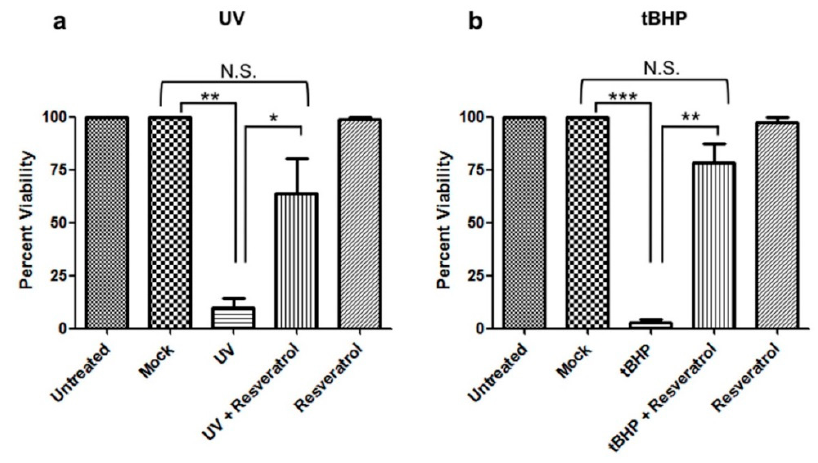
Figure 1. Resveratrol prevents apoptosis induced by UV-irradiation and tBHP treatment in C6 cells. C6 cells were pretreated with resveratrol and either ( a ) UV-irradiated or ( b ) treated with tBHP. Viability was determined 24 h later. C6 cells that were UV-irradiated or treated with tBHP showed a significant decrease ( p < 0.05) in viability compared to mock and untreated cells. C6 cells pretreated with resveratrol and then ( a ) UV-irradiated or ( b ) tBHP treated showed a significant increase ( p < 0.05) in viability compared to UV-irradiated or tBHP treated cells alone. ( a ) There was a significant difference in cell viability between mock vs. UV (**, p = 0.0026). UV treated cells pretreated with resveratrol showed a significant increase in viability vs. UV treated cells (*, p = 0.0354). Mock treated cells compared to UV treated cells pretreated with resveratrol showed no significant difference (Not Significant (N.S.), p = 0.0974). ( b ) There was a significant decrease in cell viability in tBHP treated compared to mock treated cells (***, p < 0.0001). C6 cells treated with tBHP and pretreated with resveratrol showed a significant increase in cell viability compared to tBHP treated cells (**, p = 0.0012). C6 cells treated with tBHP and pretreated with resveratrol showed no significant difference in cell viability compared to mock (N.S., p = 0.0758). All experiments were performed in triplicate and values were expressed as mean +/ − SEM.